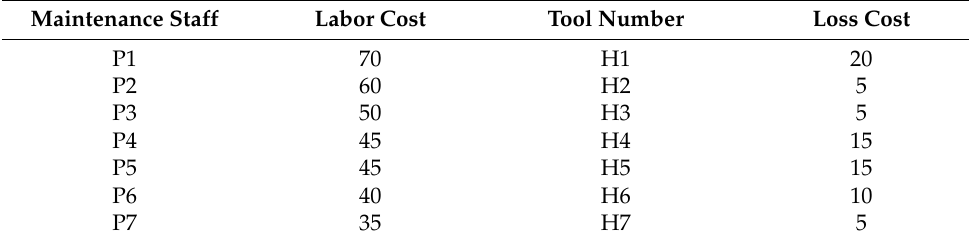
Table 5. Personnel cost and tool loss